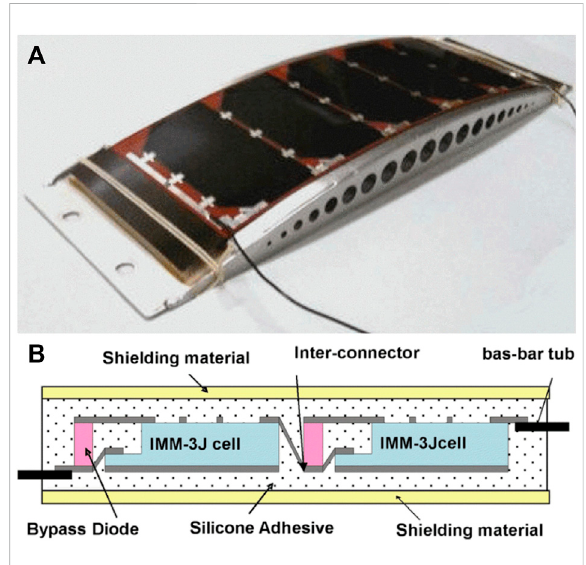
FIGURE 5 Aphotographofspacemoduleassemblyoncurvedsubstrate (A) and a cross-sectional view of a module (B) . Images adapted from (Yamaguchi et al.,